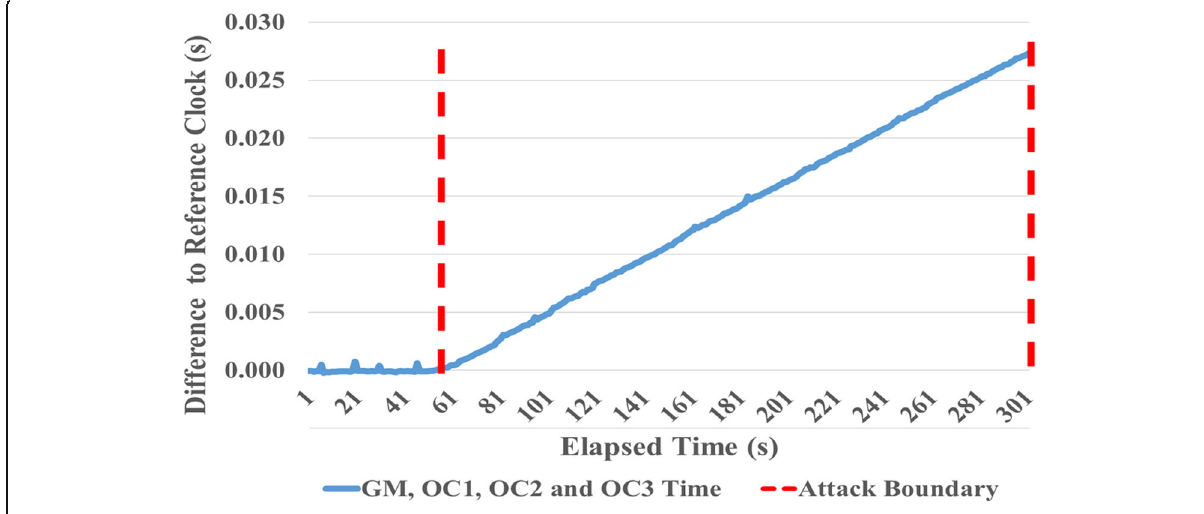
Fig. 4 Impact of BMCA or time source degradation attack on slaves